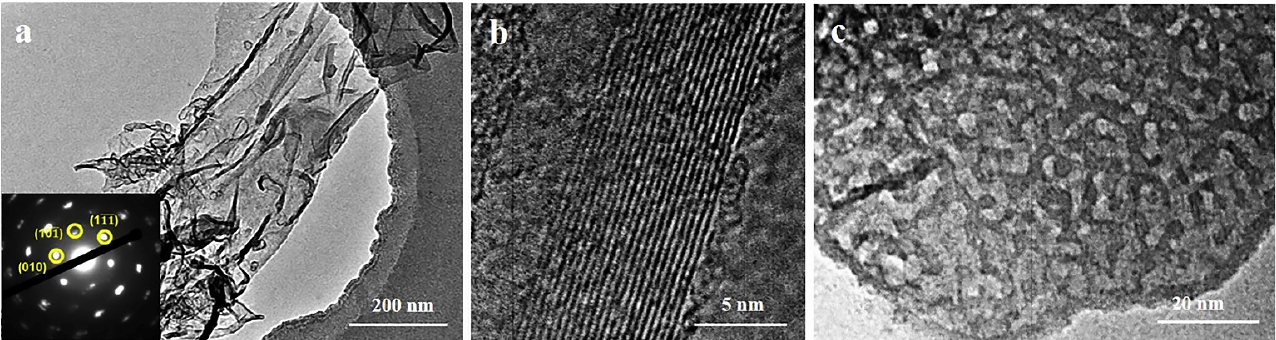
Figure 11. TEM micrographs of ( a ) Ti x Ta (4−x) AlC 3 MAX phases and ( b ) Ti x Ta (4−x) C 3 MXene. Reprinted with permission from [64].